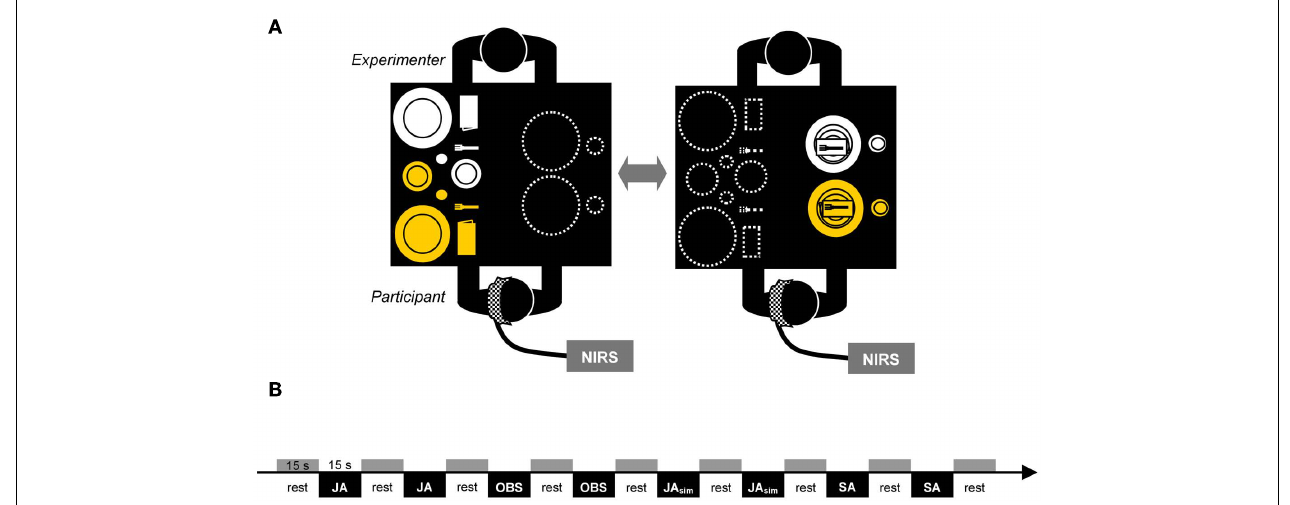
FIGURE 1 | Schematic illustration of the experimental setting. Displayed are the possible locations of the tableware after one joint action block (A) and an example section of the experimental pseudo-randomized block design (B) .